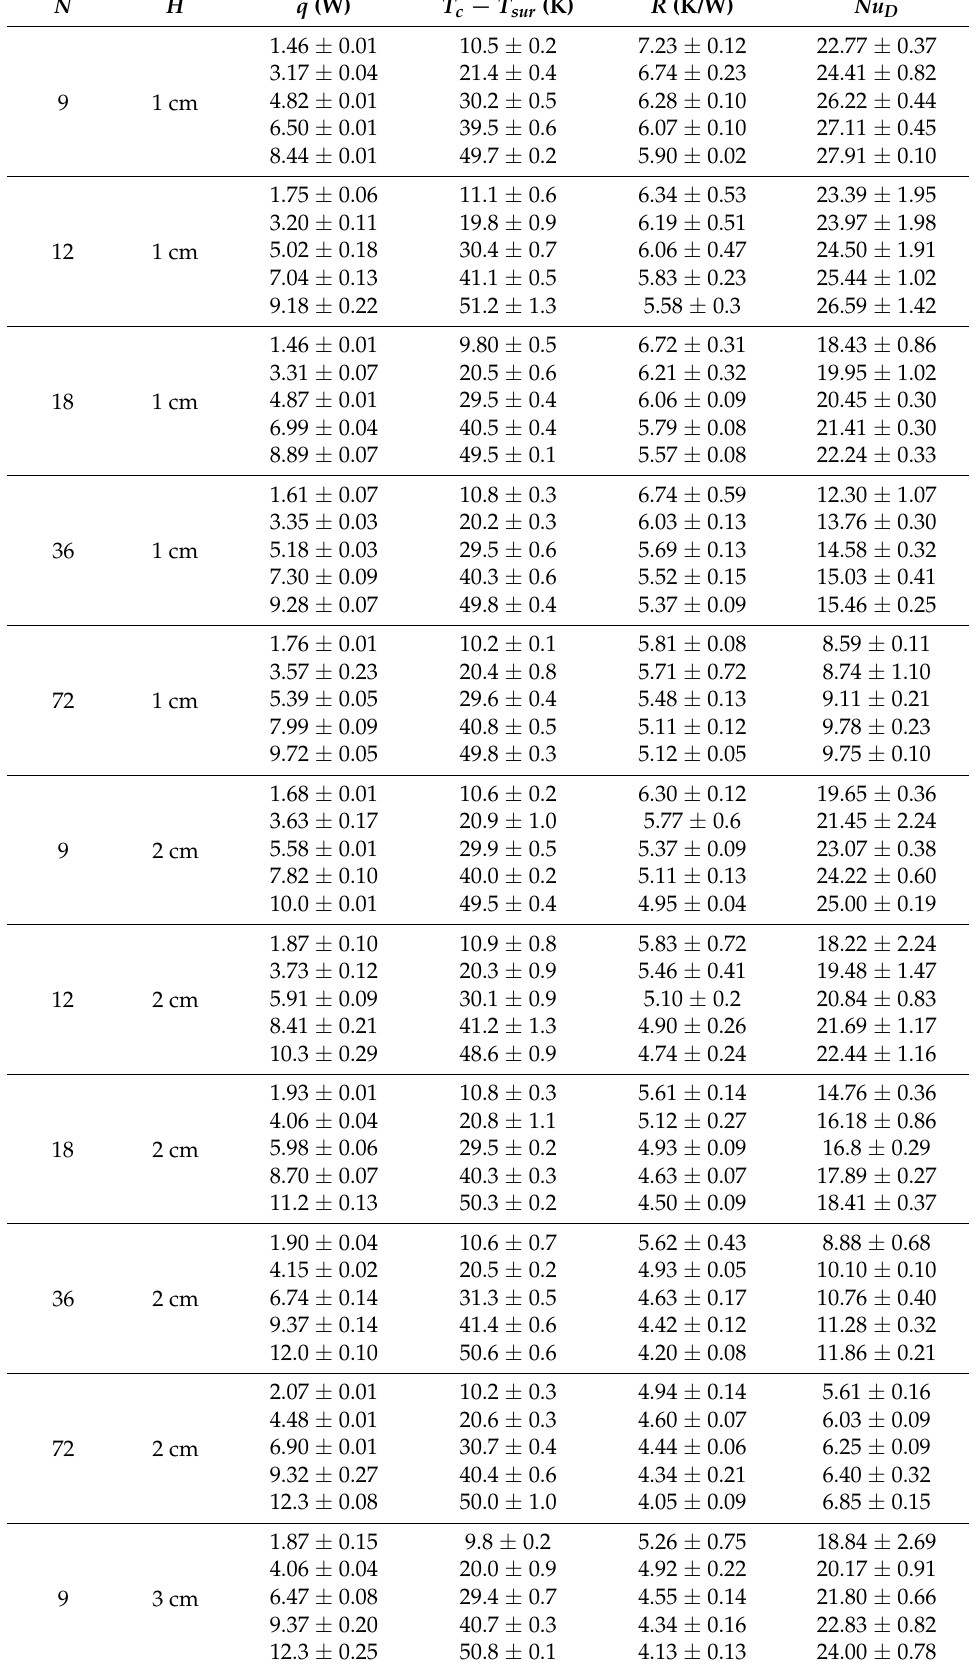
Table 3. Experimental